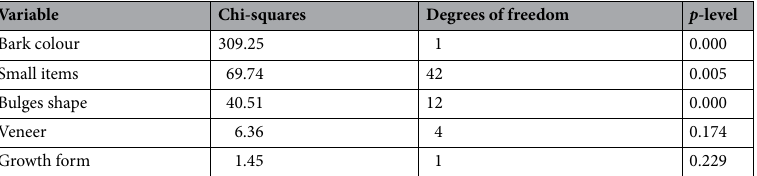
Table 2. Correspondence of the morphological traits and technical quality between parent clone and progeny plants (Bark colour—dark or white; Small items—shrubs with any type of bulges and trees with ring or sphere shape of bulges; Bulges shape—ring, dense, shallow, or sphere; Veneer—tree growth form with the external presence of shallow and dense types of bulges; Growth form—tree or shrub).